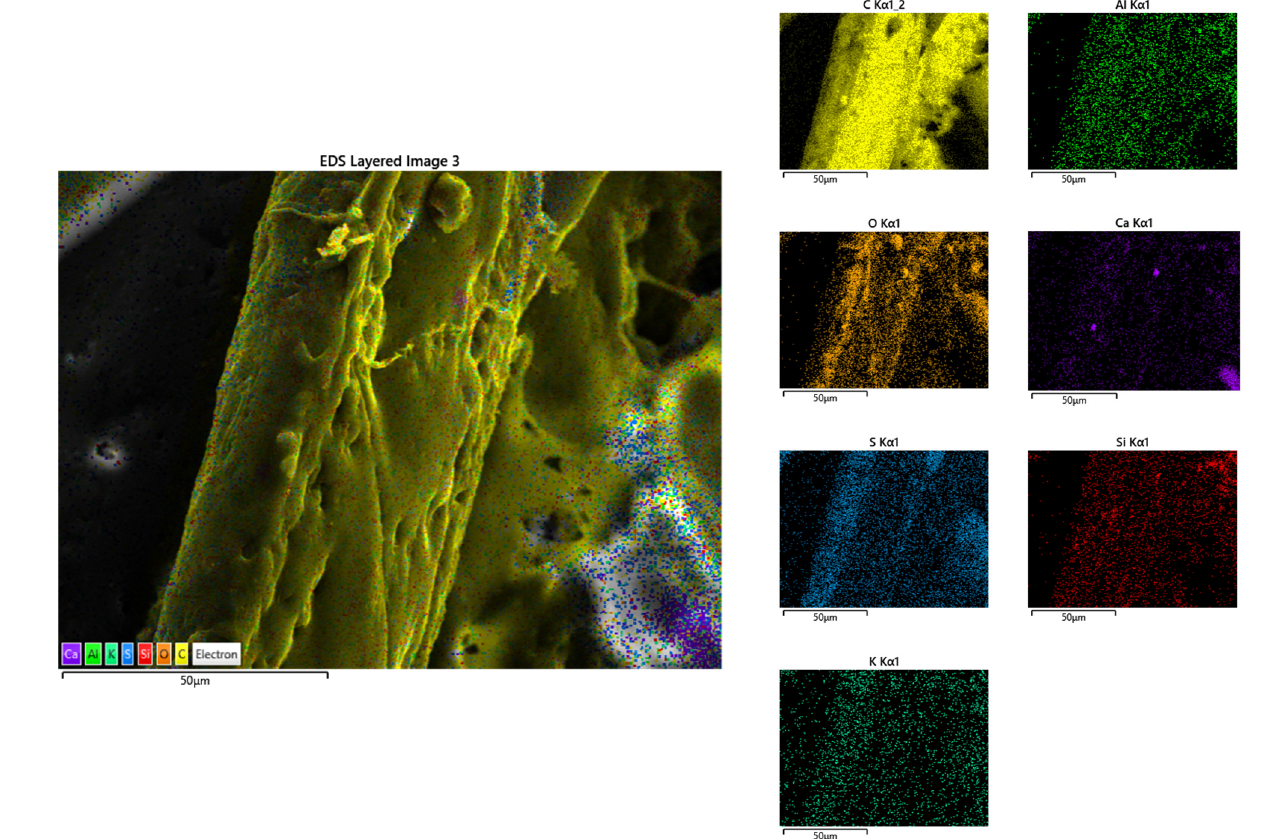
Figure 14. EDX elemental map distribution image of sample P3, magnification × 1000.